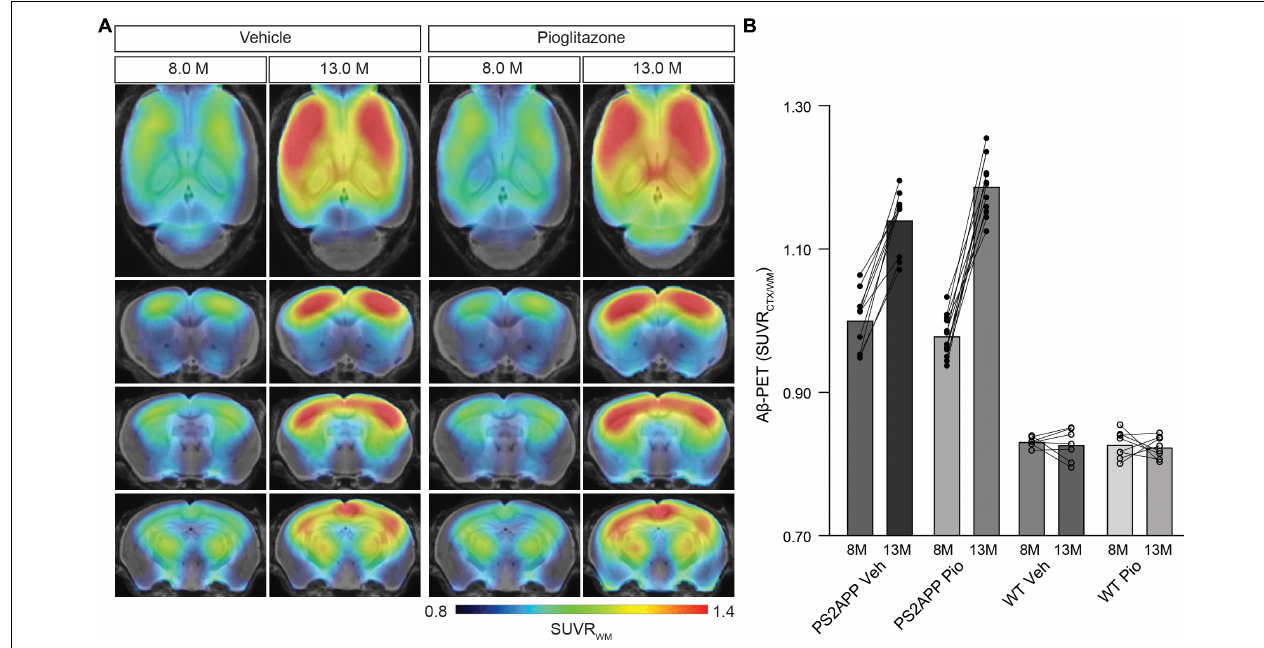
FIGURE 1 | PPAR γ stimulation in PS2APP mice provokes an increase in the A β -PET signal. (A) Regional analysis of group-averaged standardized uptake value ratio (SUVR) images of the A β -PET radiotracer [ 18 F]florbetaben in untreated and in pioglitazone-treated PS2APP mice aged 8 and 13 months. Coronal and axial slices are projected upon a standard MRI template. (B) Plots show cortical SUVR values of [ 18 F]florbetaben in PS2APP and wild-type (WT) mice between 8 and 13 months of age under vehicle (Veh) or pioglitazone (Pio) treatment. The A β -PET signal increased in PS2APP mice during aging, but the increase was more pronounced in pioglitazone treated mice [ F ( 1 , 12 ) = 12.9; p = 0.0017]. In wild-type animals, no difference was observed between untreated and treated animals during aging [ F ( 1 , 13 ) = 0.490; p = 0.496]. Data are presented as mean ± SEM. P values of Bonferroni post-hoc test result from two-way ANOVA. N = 10–13 PS2APP; N = 7–8 WT. PET images of wild-type mice are provided in Supplementary Figure 1 .